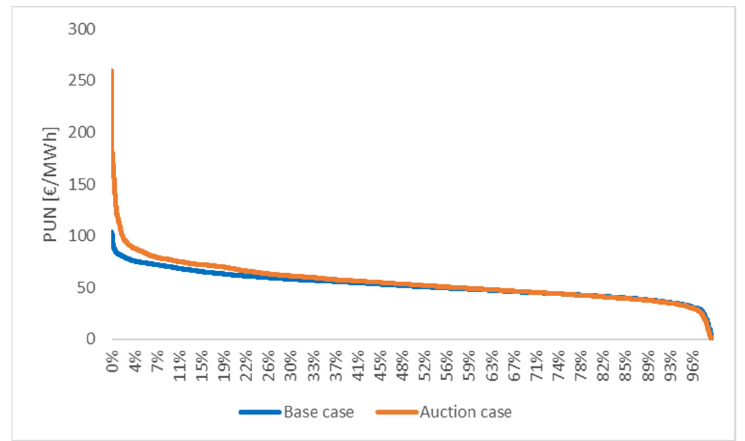
Figure 12. PUN duration curve of the Plexos base simulation and the post-auction one.